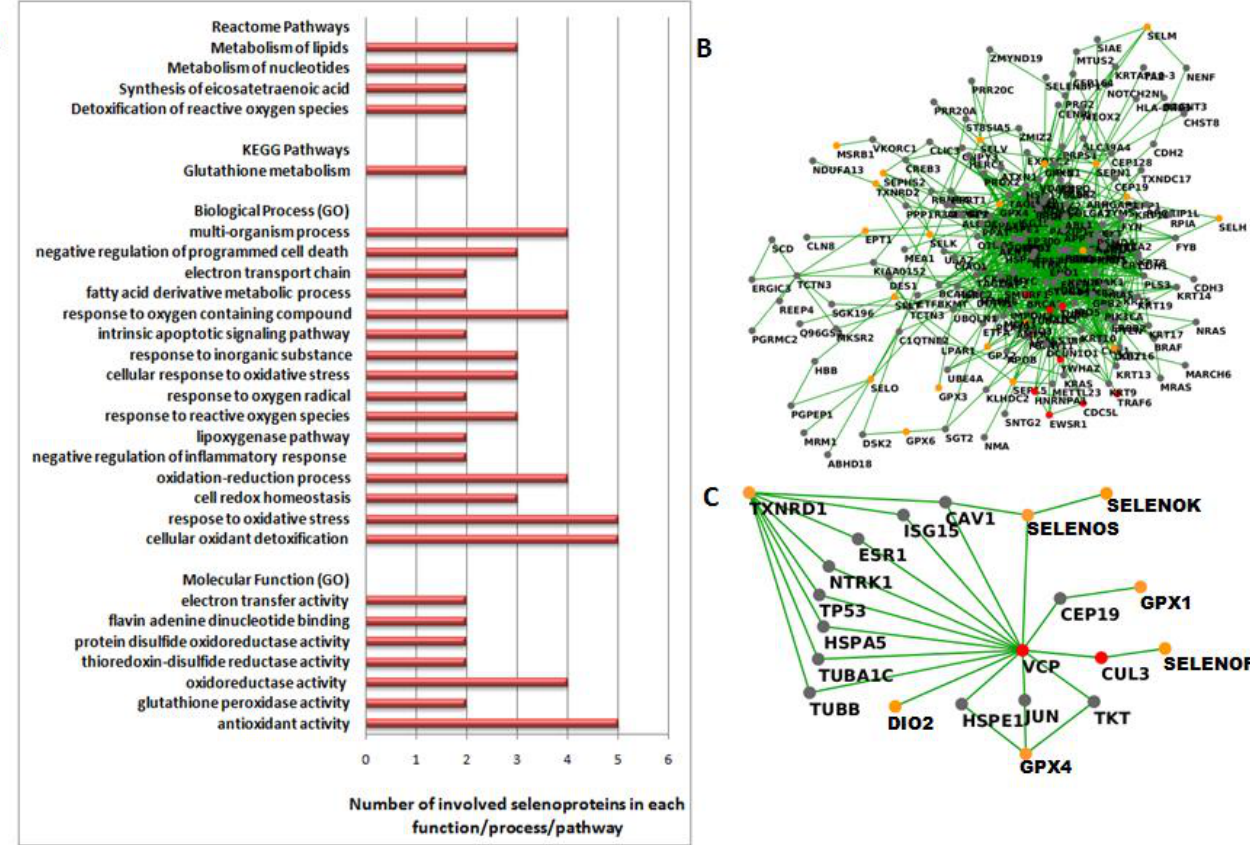
Figure 3. ( A ) Functional analysis performed by the STRING tool (https://string-db.org/ accessed on on 1 May 2020) on the five more significant selenoproteins (GPX1, GPX4, SELENOS, TXNRD1 and TXNRD3). The bars indicate the number of selenoproteins involved in each Molecular Function and Biological Process Gene Ontology (GO), and Reactome and KEGG Pathways. ( B ) First-order interaction network obtained by extracting the selenoproteins from the TNBC network. We report selenoproteins in orange, HUB nodes in red and other nodes in gray. ( C ) Sub-network related to the links between more significant selenoproteins and two HUB nodes, CUL3 and VCP/p97. We report DIO2, GPX1, GPX4, SELENOF, SELENOK, SELENOS and TXNRD1 in orange, CUL3 and VCP/p97 in red and other nodes in gray.